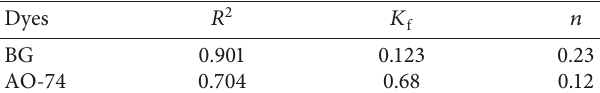
Figure 9: Graphical illustration of the Freundlich model. Table 5: Freundlich constants for elimination of dyes by PR leaves.